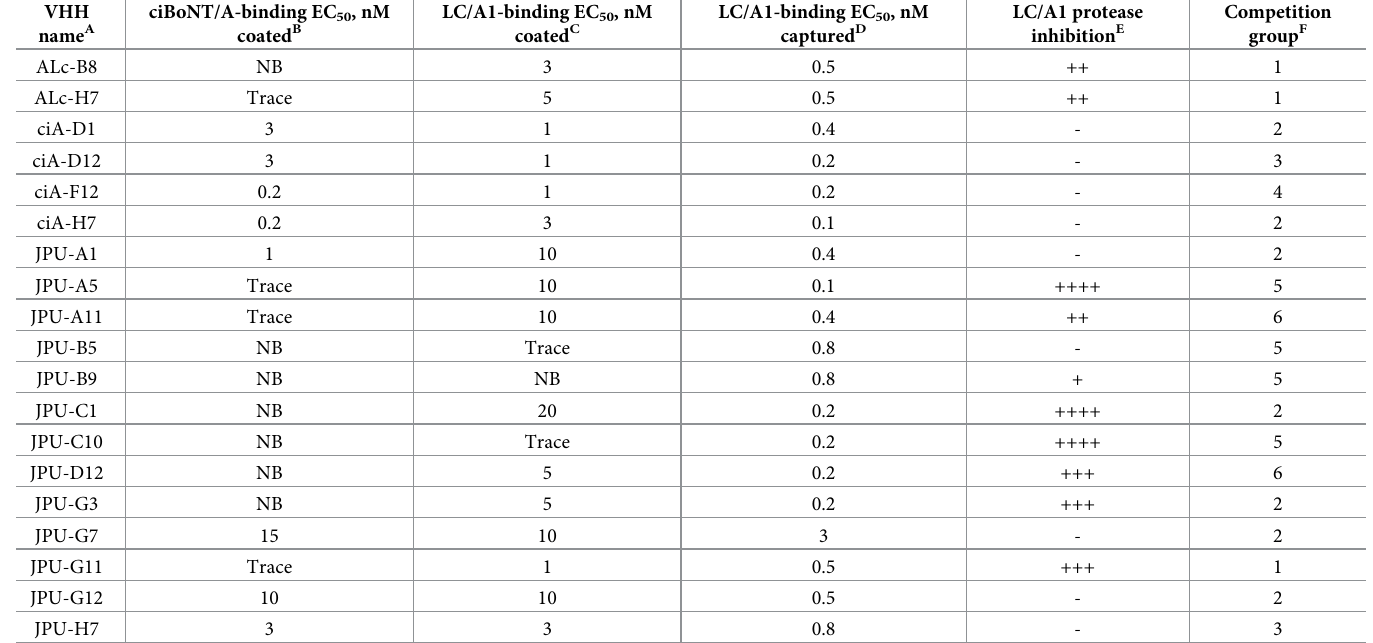
Table 1. A summary of anti-BoNT/A VHH characterization